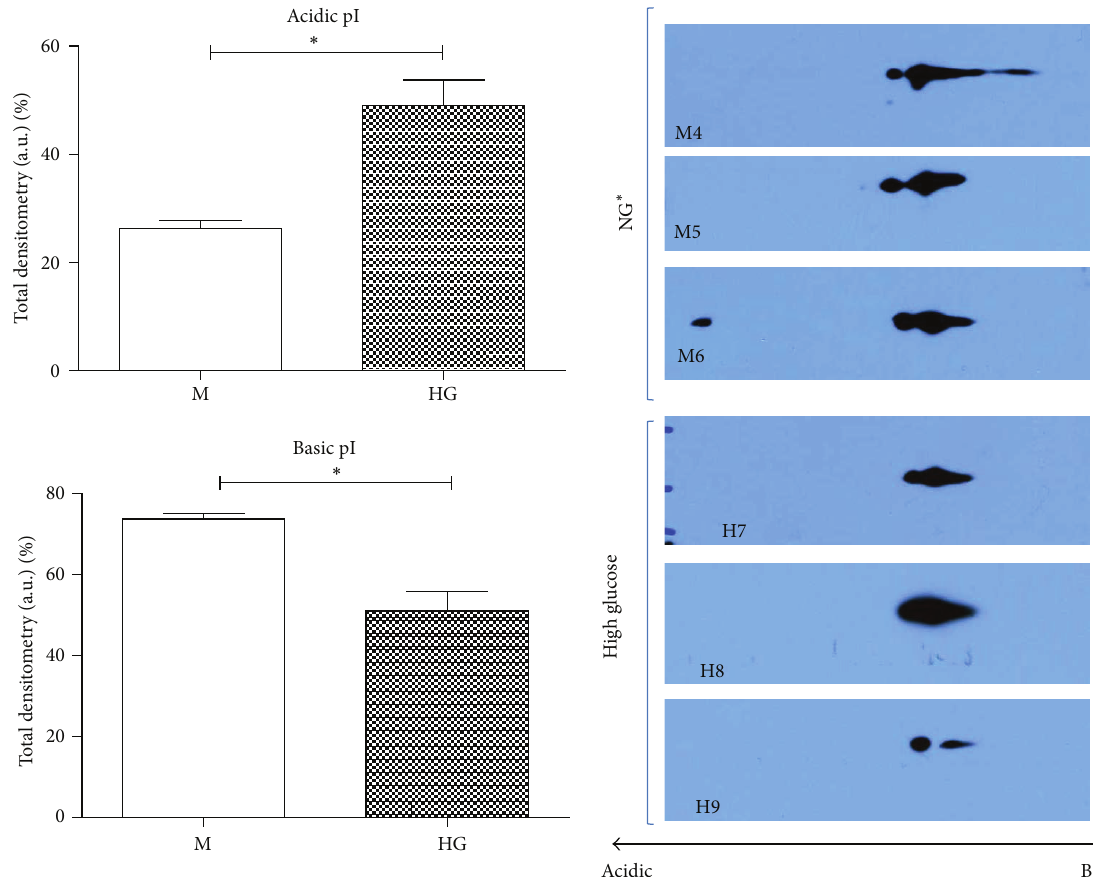
Figure 4: 2DE immunoblot experiments were used to determine the effects of HG and NG ∗ on PHB isoforms. Following the transfer and development of PHB IB, images were aligned and densitometric measurements were estimated using ImageJ for the acidic one-third of the PHBchargetrainandforthebasictwo-thirdsofthePHBchargetrain(IBimagesonright).FractionalvaluesforPHBchargetraincomponents (acid and basic ends) were used to determine statistical significance differences (left bar graphs). M is the same as NG ∗ (5 mM D-glucose + mannitol); HG is 25 mM D-glucose. ∗ 𝑝 value <